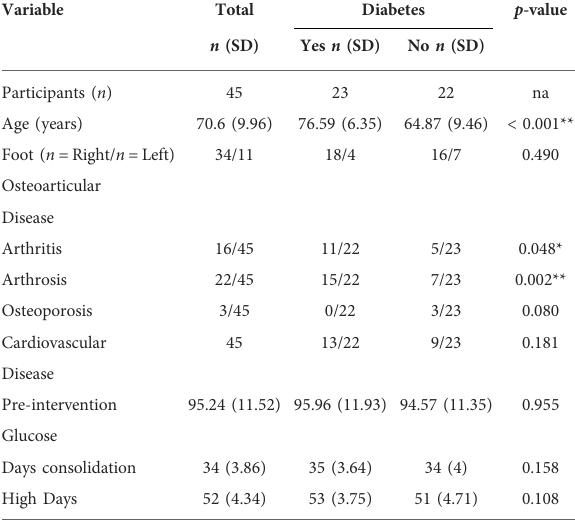
TABLE 1 Participants characteristics included in the present